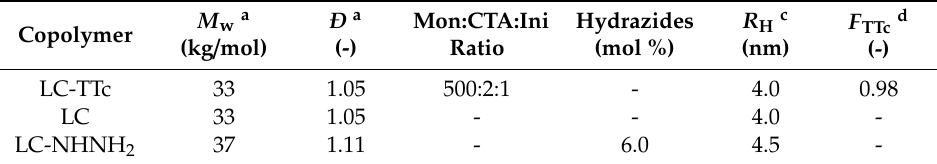
Table 1. Characterization of copolymer